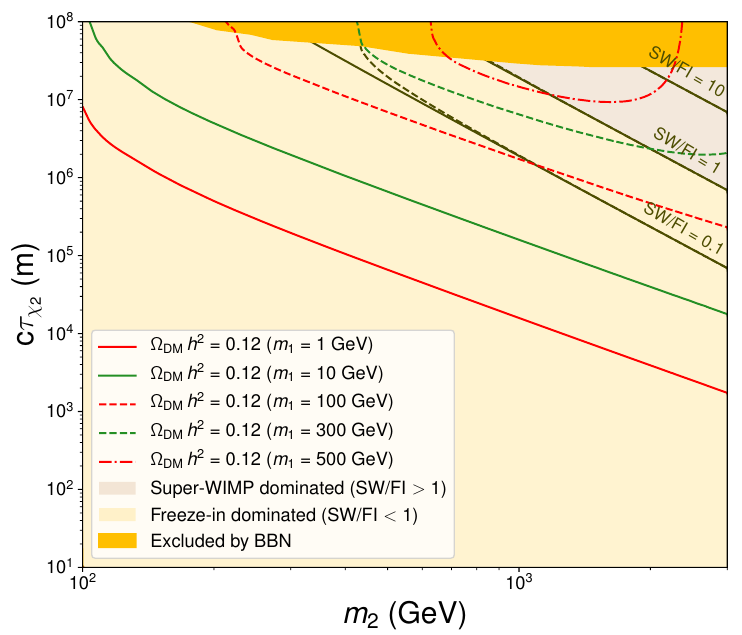
Figure 4 . Values of the SW/FI ratio ( m 1 (cid:10) 2 h 2 ) = ( m 2 (cid:10) 1 h 2 ) in the ( m 2 , c (cid:28) (solid black lines) and m 1 = 300 GeV (dashed black lines). The red/green lines correspond to the DM relic abundance condition (cid:10) DM h 2 = 0 : 12 for various choices of the DM mass m 1 . The Yellow region is excluded by BBN (see section